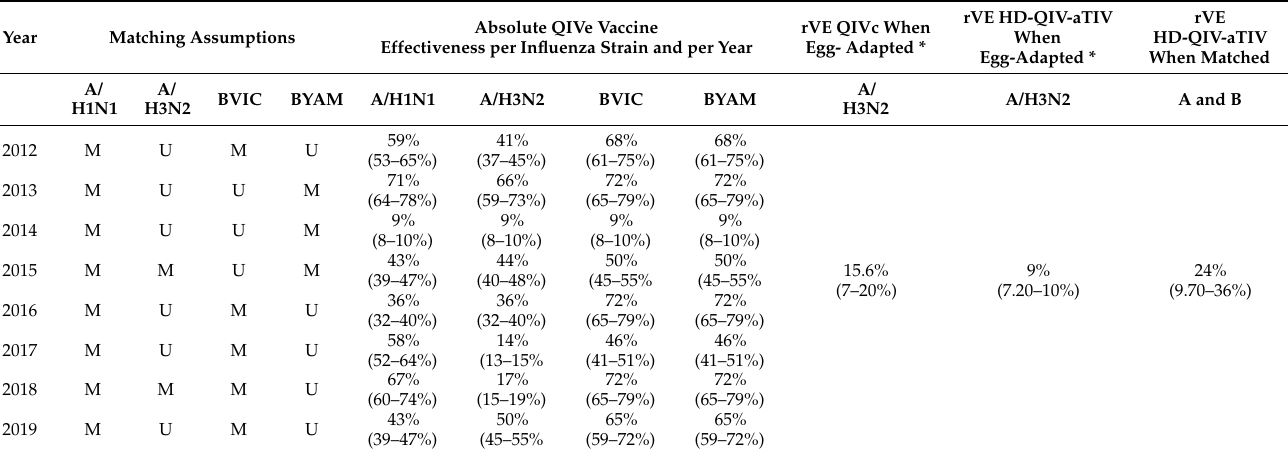
Table 1. Parameters used in the epidemiological